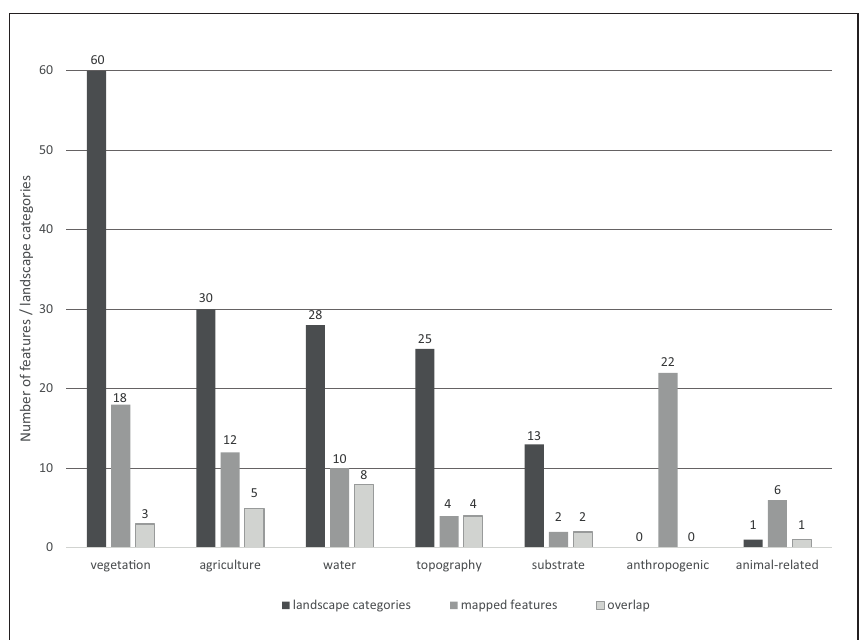
Figure 7. Comparison between ethnoecological landscape categories and features on sketch maps, including